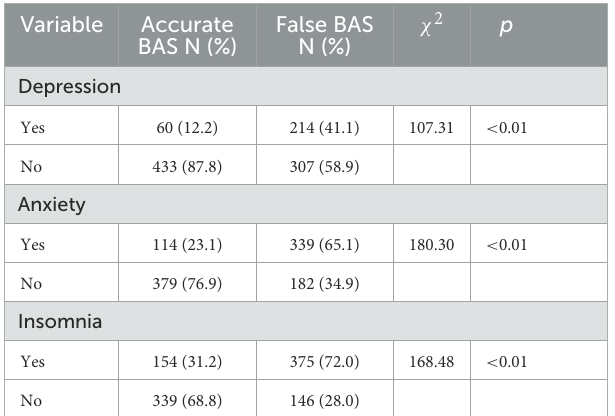
TABLE 4 Prevalence of depression, anxiety and insomnia according to respondents’